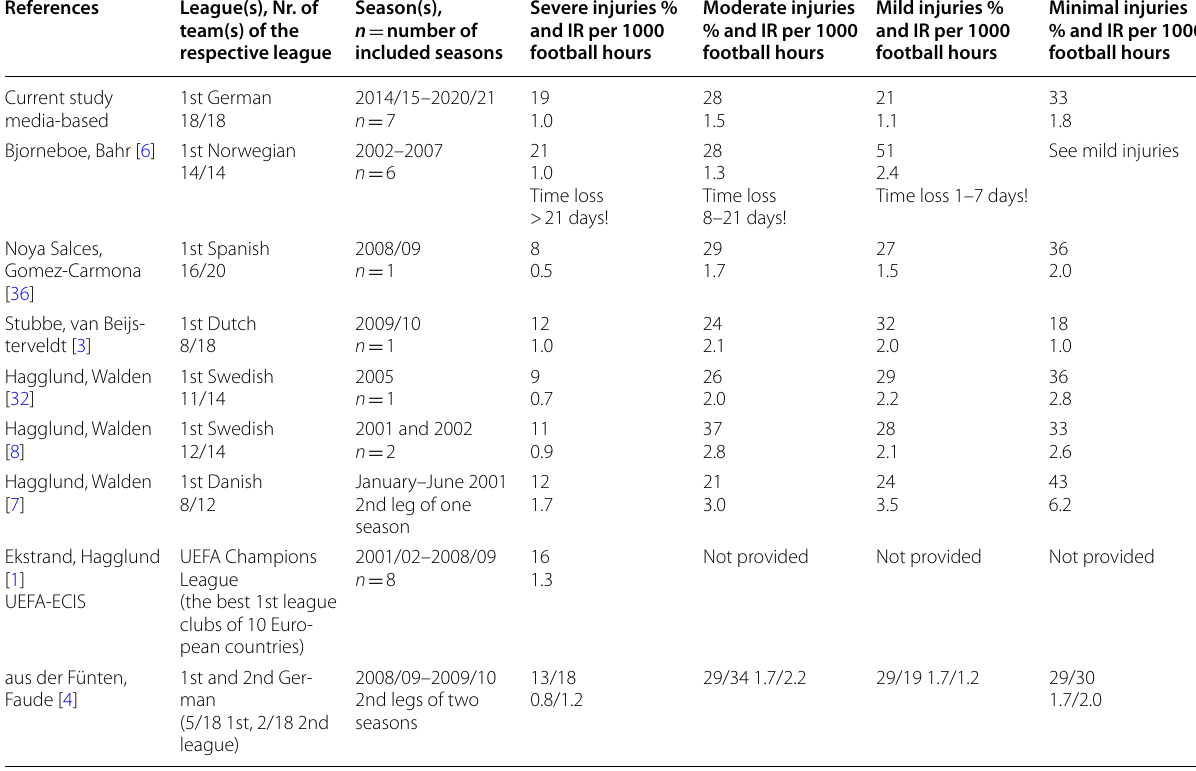
Table 8 (Inter)national comparison of injury